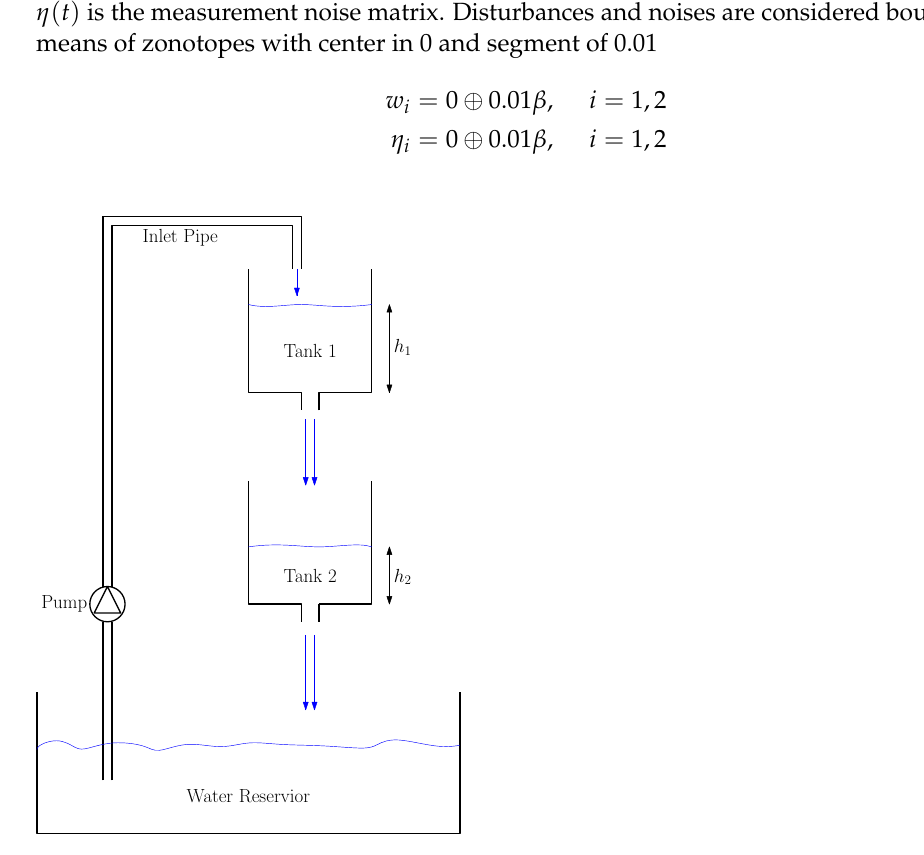
Figure 3. Schematic diagram of the two-tank